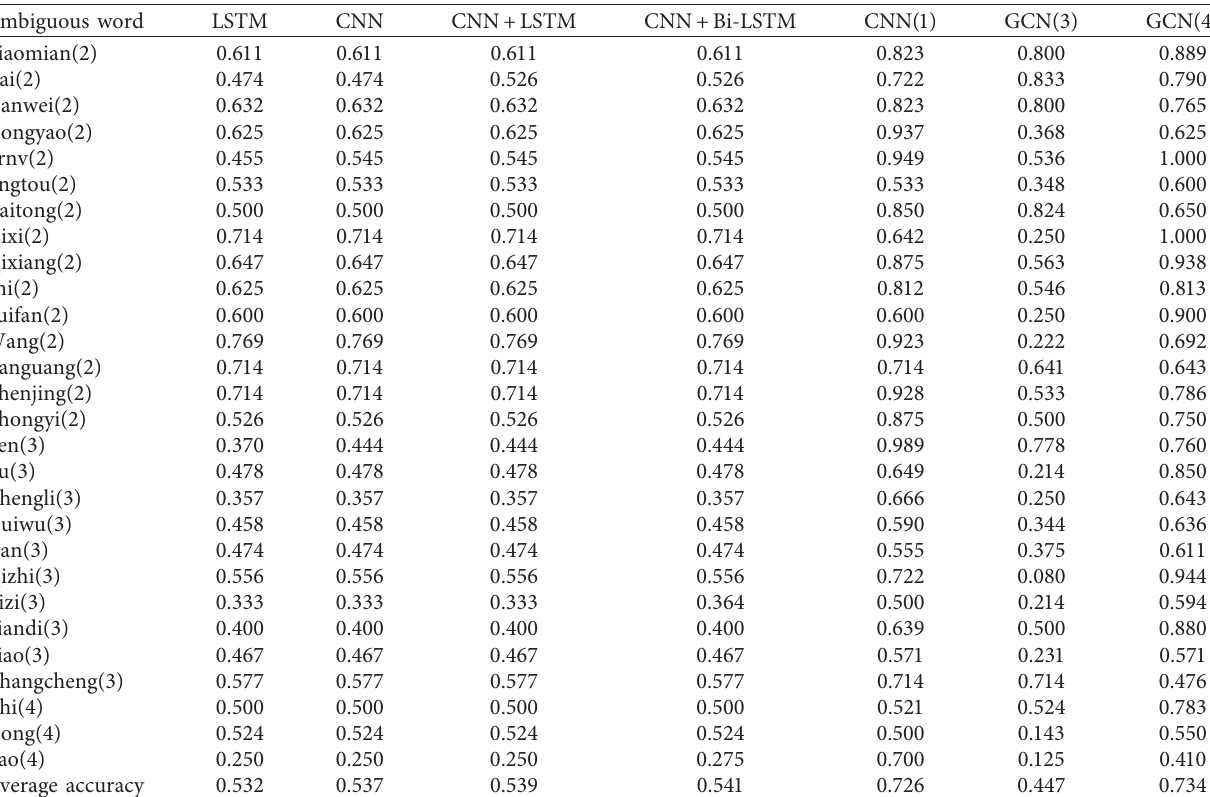
Table 2: Disambiguation accuracies in the second group of